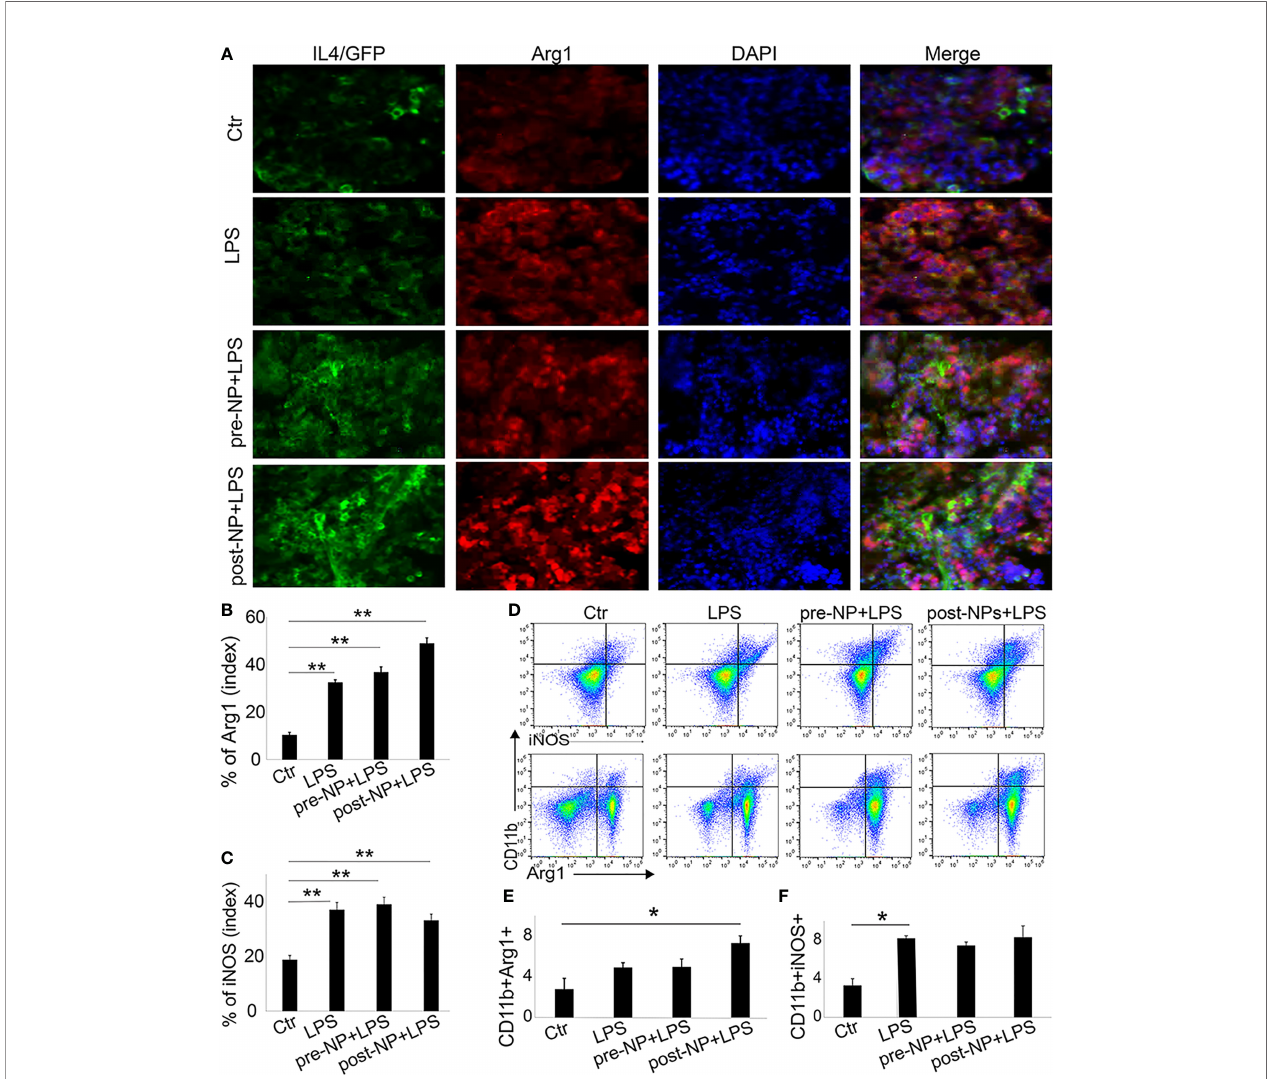
FIGURE 8 | Spleen macrophages respond to IL-4pDNA-NPs in a mouse model of in fl ammation. (A) A histological assay was performed in an in fl ammation mouse model that was treated with IL-4pDNA-NPs 24 hours before (pre-NP+LPS) or after (post-NP+LPS) LPS induction. LPS-in fl ammation mice (LPS) and normal animals (Ctr) served as controls. The spleen sections from all experimental mice were stained with antibodies to IL-4 ( A , green) and the M2 marker arginase 1 (Arg 1) ( A , red). Microscopy images showed that overexpression of IL-4+ in IL-4pDNA-NP treated mice correlated with the increases of Arg-1 in spleen sections. Quanti fi cation of Arg-1 positive staining (B) showed a signi fi cant increase in both IL-4pDNA-NP pre-and post-treated LPS mice when compared to untreated in fl ammatory mice. This suggests M2 polarization by IL- 4pDNA-NPs treatment. (C) The in fl ammatory M1 marker iNOS was overexpressed in LPS-mice. IL-4pDNA-NPs treatment to LPS-mice inhibited iNOS expression. (D) Representative fl ow cytometry plots illustrated the typical gating strategy to identify CD11b+Arg-1+ and CD11b+iNOS+ macrophages in spleen. (E) The percentages of CD11b+/Arg-1+ macrophages showed a signi fi cant increase in IL-4pDNA-NP treated LPS mice. (F) LPS enhanced CD11b+/iNOS+ macrophages in spleen. No signi fi cant changes were seen in LPS-mice with or without IL-4pDNA-NPs treatment. Signi fi cance was evaluated with a one-way ANOVA followed by Tukey ’ s post-hoc analysis. Error bars represent s.e.m. * p < 0.05, ** p <